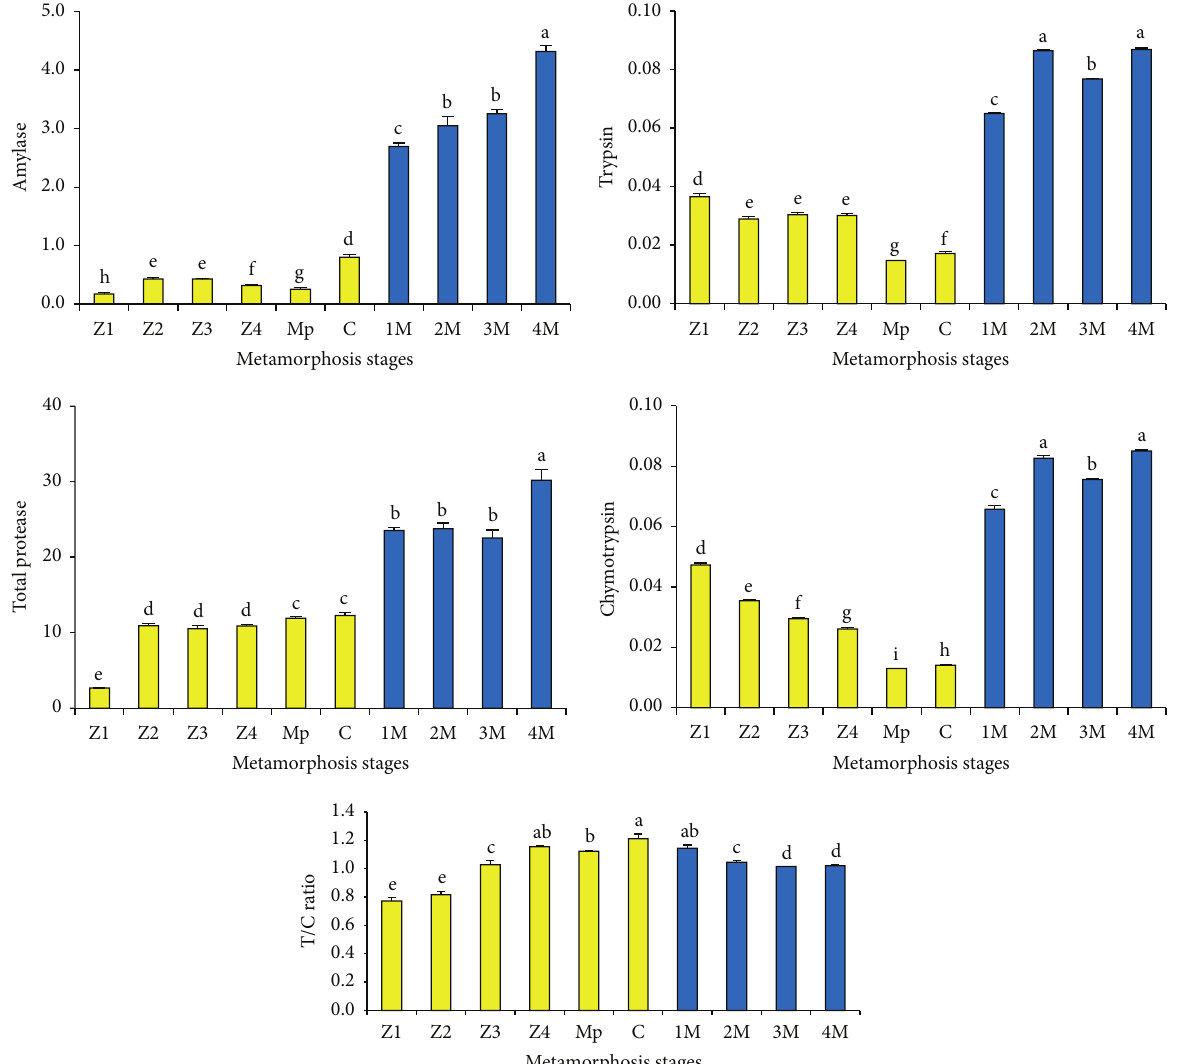
Figure 2: Specific activities of digestive enzymes, amylase ( 𝜇 mol maltose min −1 mg protein −1 ), total protease (Umg protein −1 ), trypsin and chymotrypsin ( 𝜇 mol p -nitroaniline min −1 mg protein −1 ), and activity ratio of trypsin to chymotrypsin (T/C ratio) of P. pelagicus during metamorphosis, at different larval stages (zoea, Z1–Z4; megalopa, Mp; first crab, C) and different adult stages (1M–4M). Vertical bars indicate ± SEM ( 𝑛 = 5 ). The bars with different superscripts are significantly different ( 𝑃 < 0.05 ).